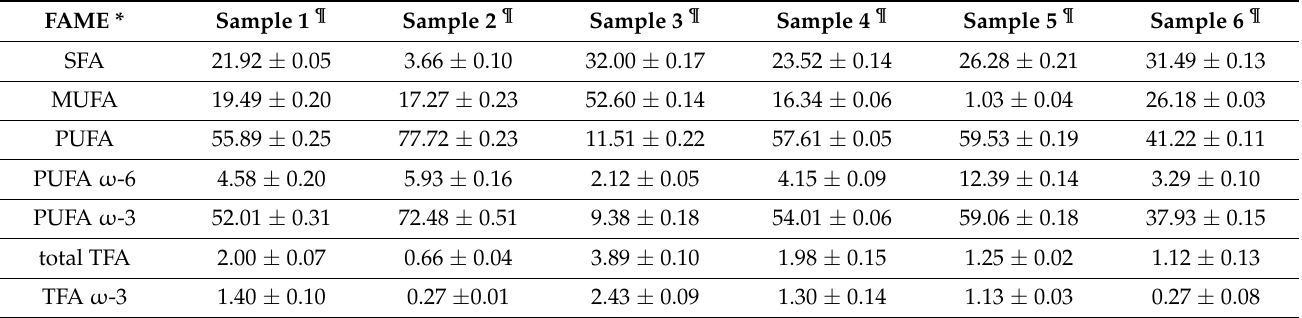
Table 3. Some fish oil composition found in current supplements on the market (data extracted from ref.